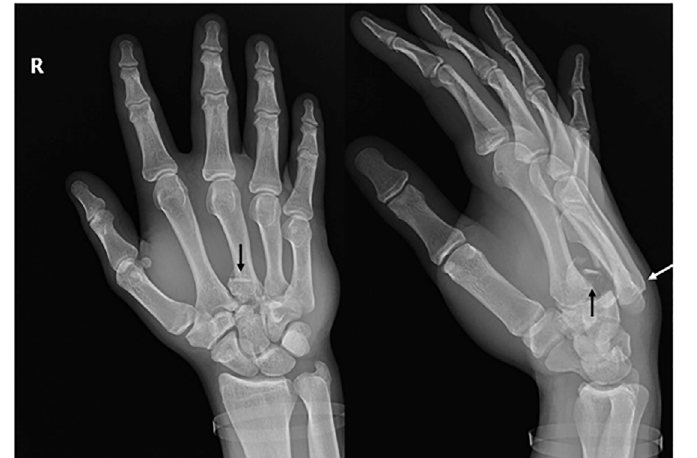
Image. Anterior-posterior and oblique plain radiograph of the right hand demonstrates fractures through the radial aspect of the base of the third metacarpal (black arrows) with dorsal carpometacarpal dislocations of the third through fifth metacarpals (white